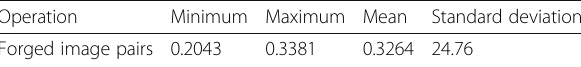
Table 6 Normalized hamming distance for 800 forged image pairs